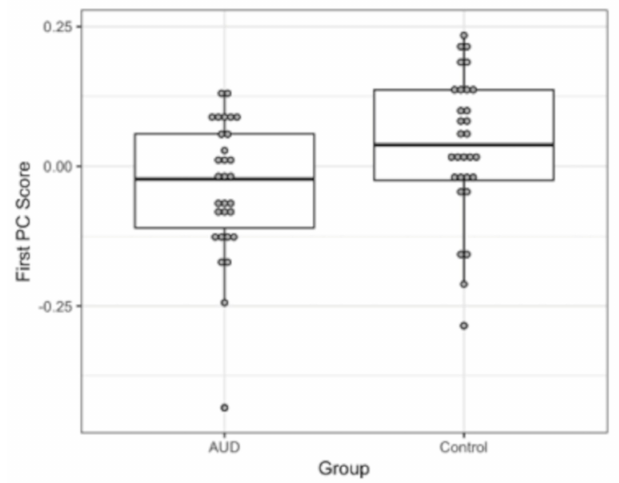
Figure 3. Boxplots of the 1st principal component scores in the AUD and control groups. The scores were significantly different ( p < 0.02) between groups, as determined by a nonparametric Mann–Whitney U